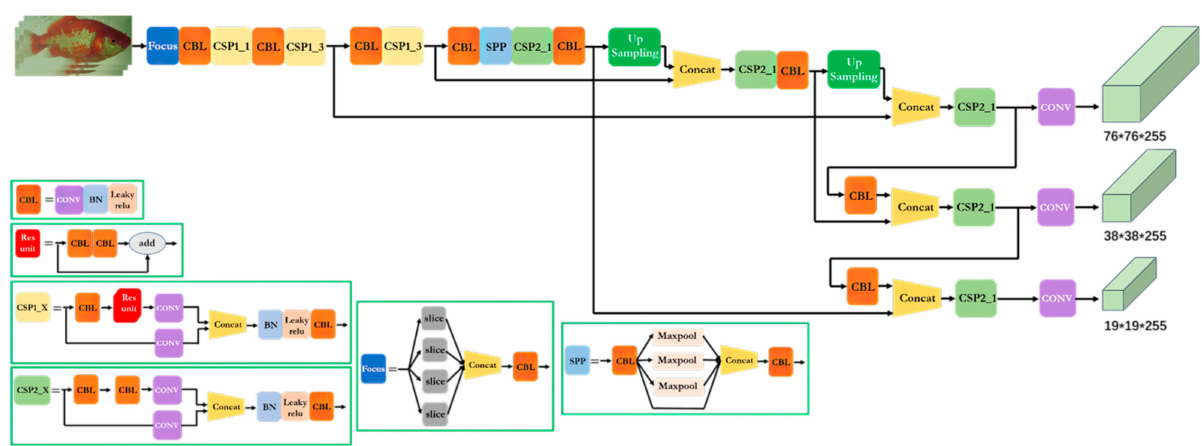
Figure 9. The network structure and application of Yolo 5. The CBL component in the figure is composed of the Convo- lutional layer + BatchNormalization + Leaky_relu activation function. The Res-unit component draws on the residual structure in the Resnet network and can play a role in building a deeper network. The CSP_X component draws on the CSPNet network structure and is composed of a convolutional layer and X Res-unit modules. The focus component is to slice the data, which can play a role in the down-sampling operation without information loss. The SPP component adopts the maximum pooling method of 1 × 1, 5 × 5, 9 × 9, and 13 × 13 for multi-scale